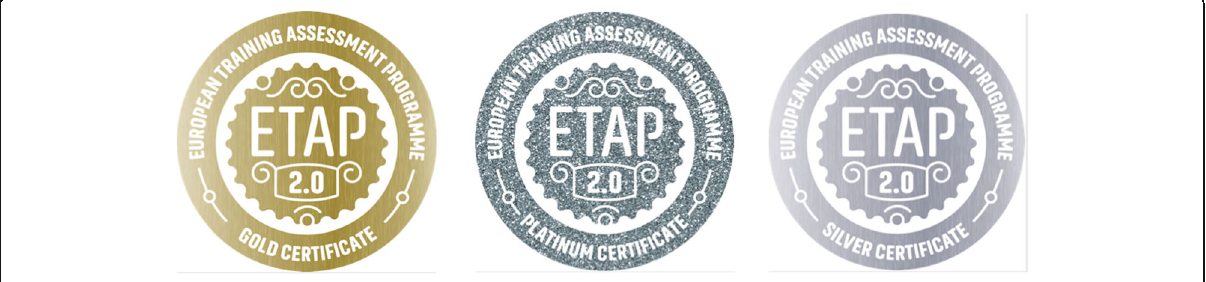
Fig. 3 ETAP 2.0 certification ribbons (Gold, Platinum,